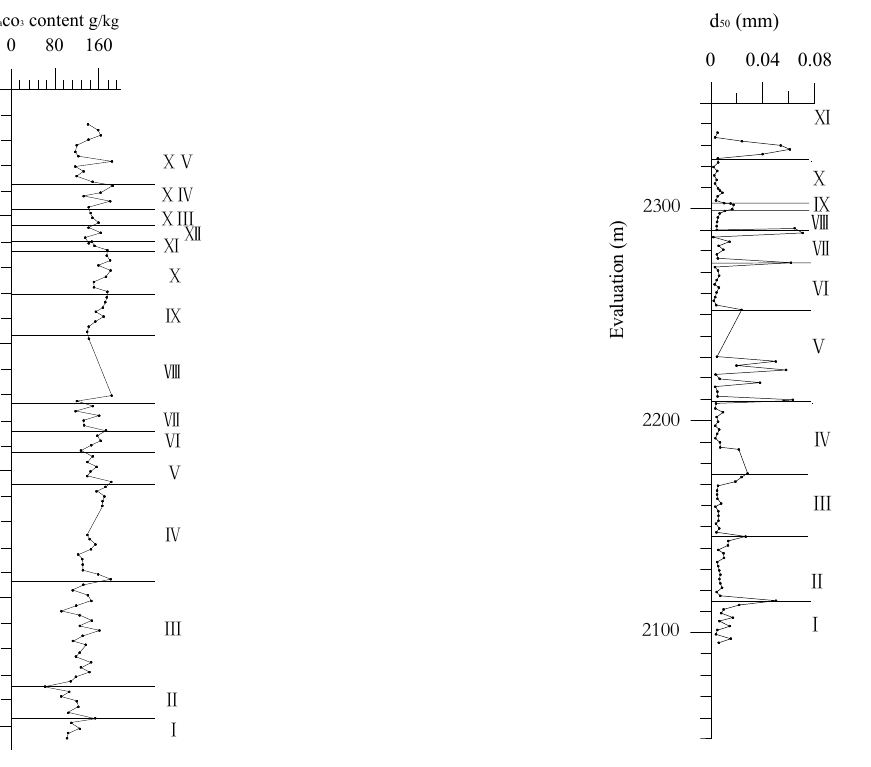
Fig. 9. Mean particle size, d 50 Figure 9. Mean particle size, d 50